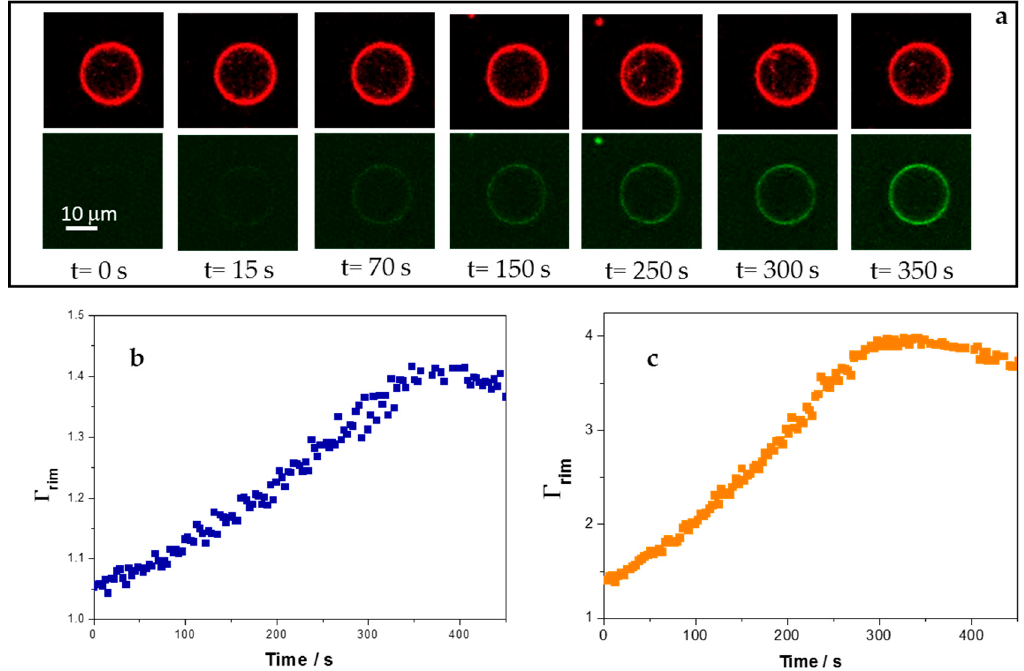
Figure 5. Interaction of 5-FAM-KR 9 C with giant unilamellar vesicles (GUVs) composed of DOPC / DOPG and DOPC / CHOL / DOPG. ( a ) Representative images of a single DOPC / CHOL / DOPG GUV at the indicated times after the outside fluoresce reached a constant value (2.5 µ M peptide). Top panels: Rho-PE, bottom panels: 5-Figure. ( b ) Γ rim = ratio of the fluorescence at the GUV’s rim and at regions outside the GUV after addition of 2.5 µ M peptide for membranes of DOPC / DOPG. ( c ) Γ rim after addition of 2.5 µ M peptide for DOPC / CHOL / DOPG membranes. ( b , c ) correspond to the data of a single GUV in a representative